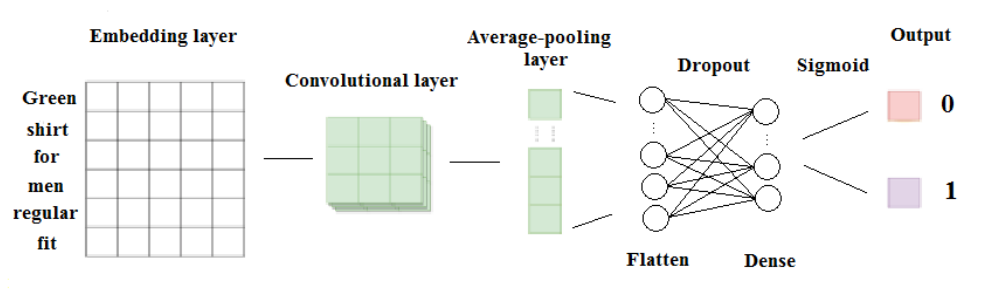
Figure 2. Overview of the CNN-based classification